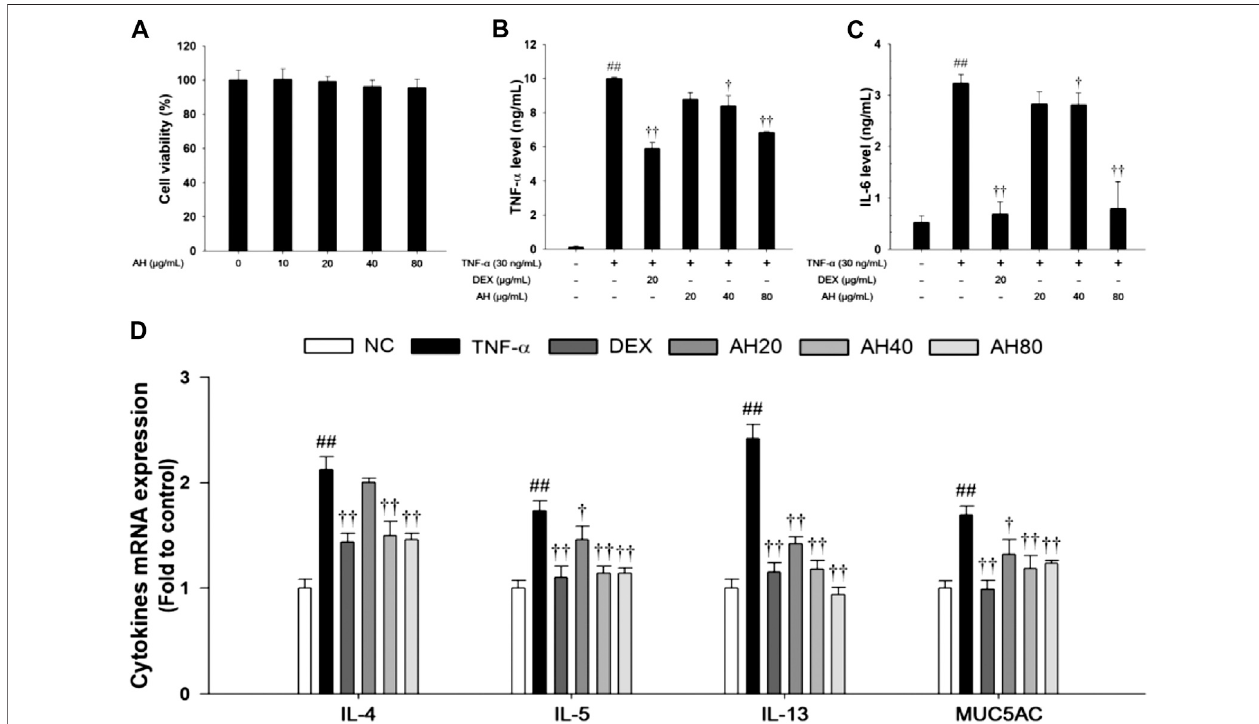
FIGURE 6 | Effects of AH on cell viability, in fl ammatory cytokines (TNF- α , IL-6), Th2 cytokines (IL-4, IL-5 and IL-13) and MUC5AC in TNF- α -stimulated NCI-H292 cells. The (A) cell viability was measured using a WST-1 reagent, and AH was treated with 10, 20, 40 and 80 μ g/ml for 24 h. The levels of (B) TNF- α and (C) IL-6 was determinedbyELISA.Theculture medium werechangedRPMI1640(0.1% FBS)and treatedwithAH(20,40and80 μ g/ml)for1 hand incubated withTNF- α (30 ng/ml) for 24 min (TNF- α , IL-6). (D) The mRNA levels of IL-4, IL-5, IL-13 and MUC5AC were measured by real-time PCR in TNF- α -stimulated NCI-H292 cells. Cells were treated with AH (20, 40 and 80 μ g/ml) for 1 h and incubated with TNF- α (30 ng/ml) for 18 h. NC: Normal control NCI-H292 cells; TNF- α : TNF- α -stimulated NCI-H292 cells; DEX: dexamethasone (20 μ g/ml) + TNF- α -stimulated NCI-H292 cells; AH: AH (20, 40 and 80 mg/kg) + TNF- α -stimulated NCI-H292 cells. The values are expressed as the means ± SD (n (cid:2) 3). ## p < 0.01, Signi fi cantly different from control; † , †† p < 0.05, p < 0.01, signi fi cantly different from TNF- α -treated